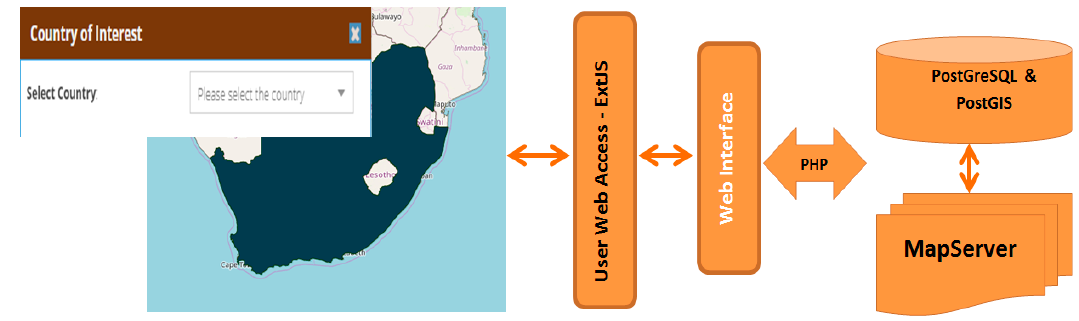
Figure 2. Example of a user query pipeline. Country selection examples from a user click query.